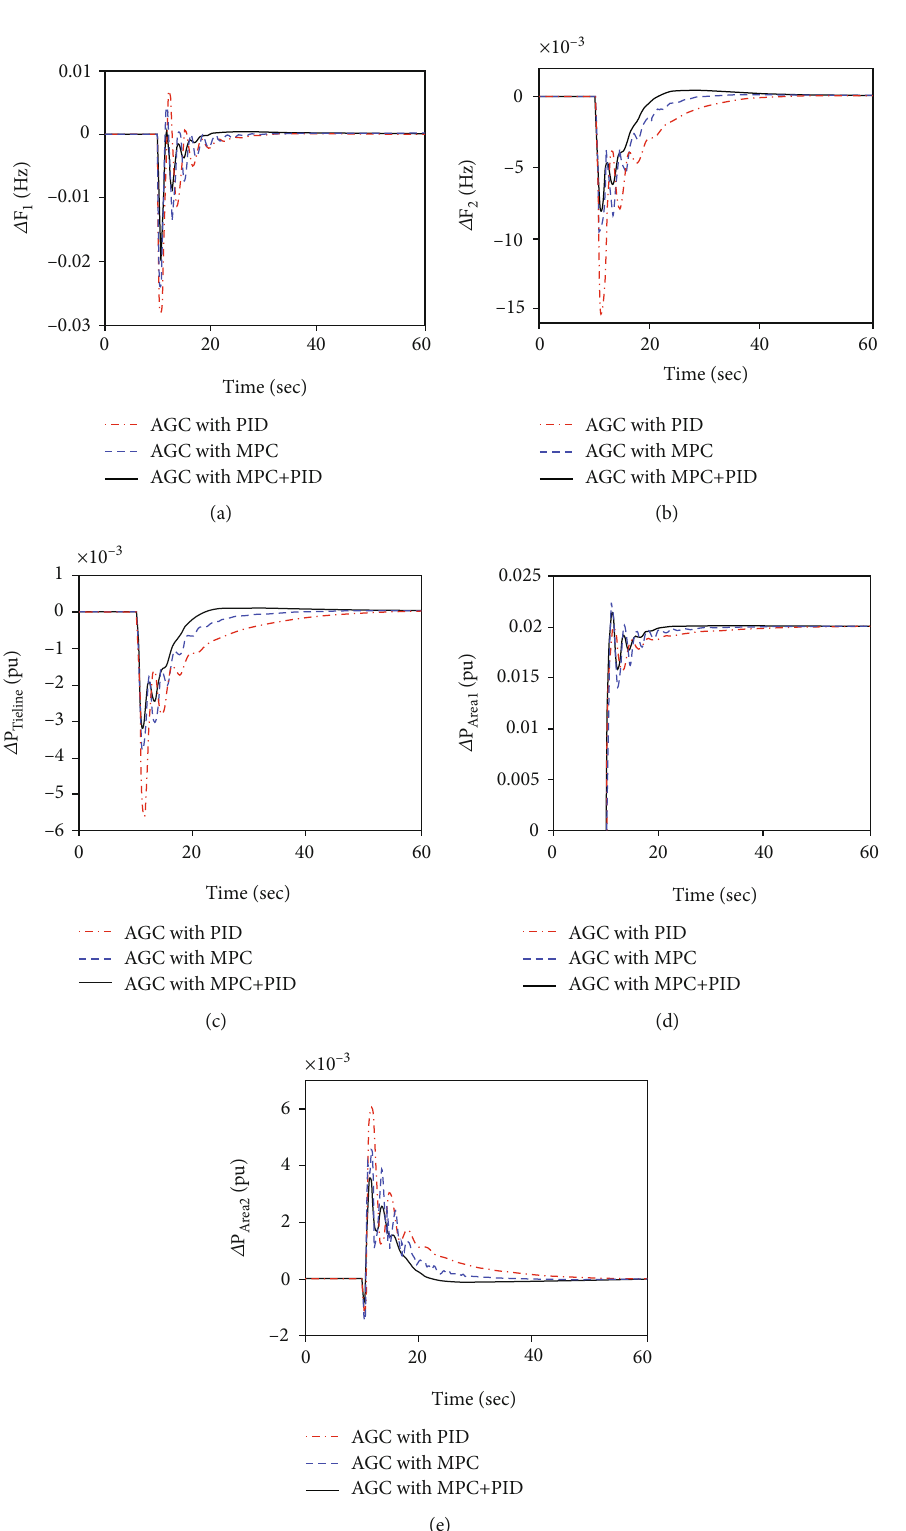
Figure 3: Dynamic performance of multisource power system model for 2% load disturbance in area-1. (a) Δ F (c) Δ P tie vs. time, (d) Δ P area − 1 vs. time, and (e) Δ P area − 2 vs.